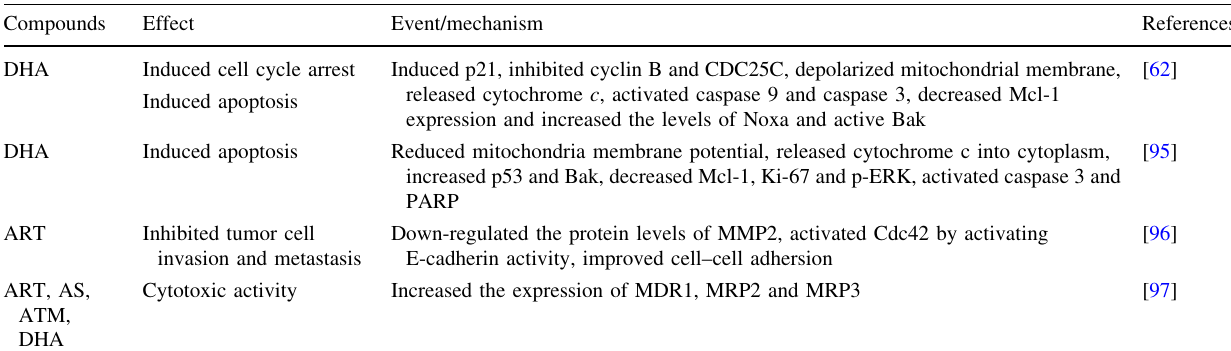
Table 4 Anti-liver cancer cells activities of artemisinins